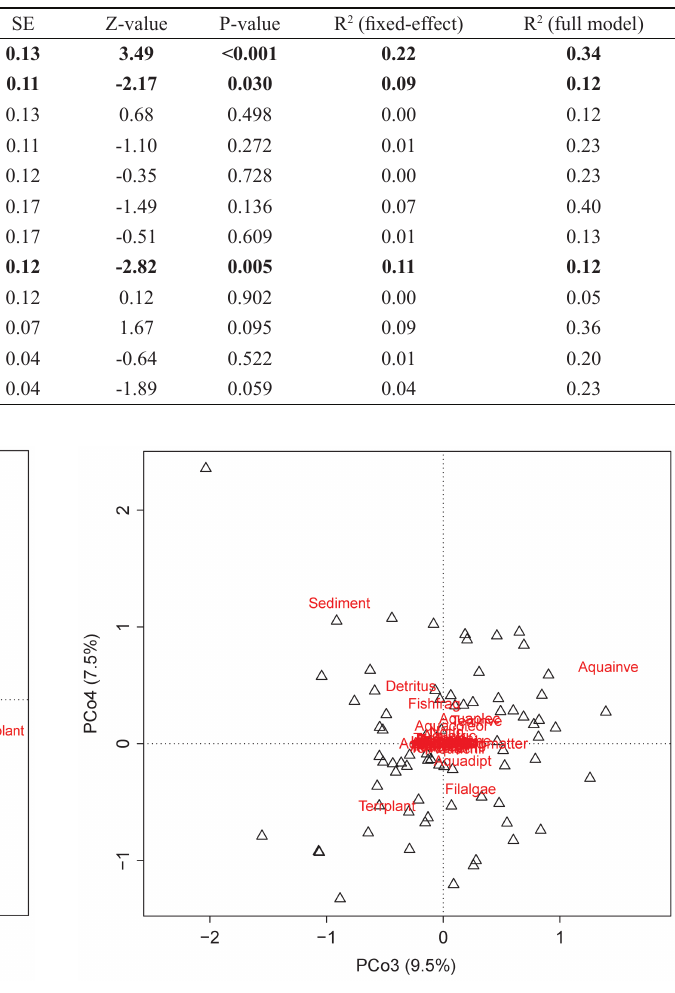
Fig. 3. Principal Coordinate Analysis (PCoA) showing PCo3 and PCo4 based on Bray-Curtis dissimilarities of diet composition of 75 individuals of the stream-dwelling characid Deuterodon stigmaturus . Food items name abbreviations are listed in Table 3.